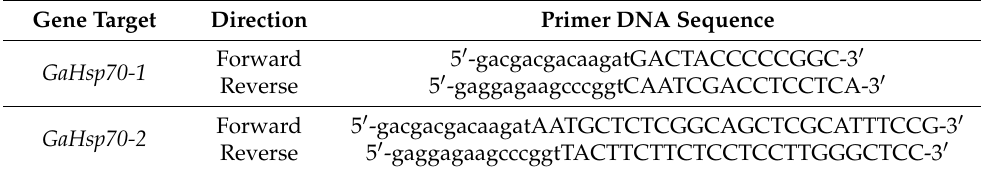
Table 3. Primers used for ligation independent cloning (LIC). Gene Target Direction Primer DNA